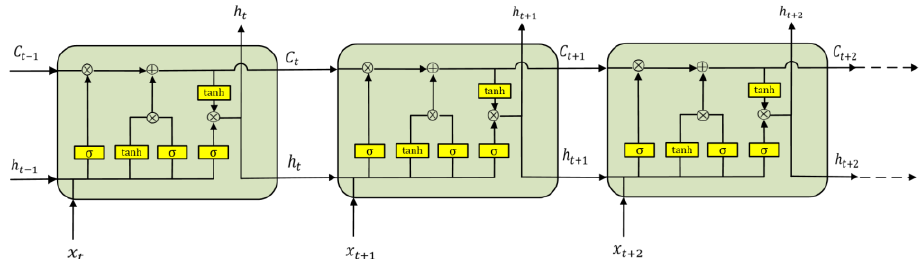
Figure 2. LSTMNN structural unit diagram.